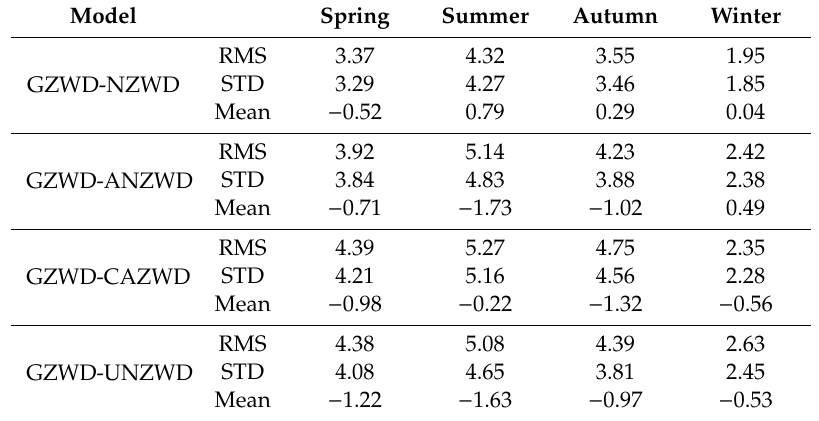
Table 4. Seasonal statistics of deviations between GZWD and models-derived ZWD (Unit: cm). Model Spring Summer Autumn Winter RMS 3.37 4.32 3.55 1.95 GZWD-NZWD